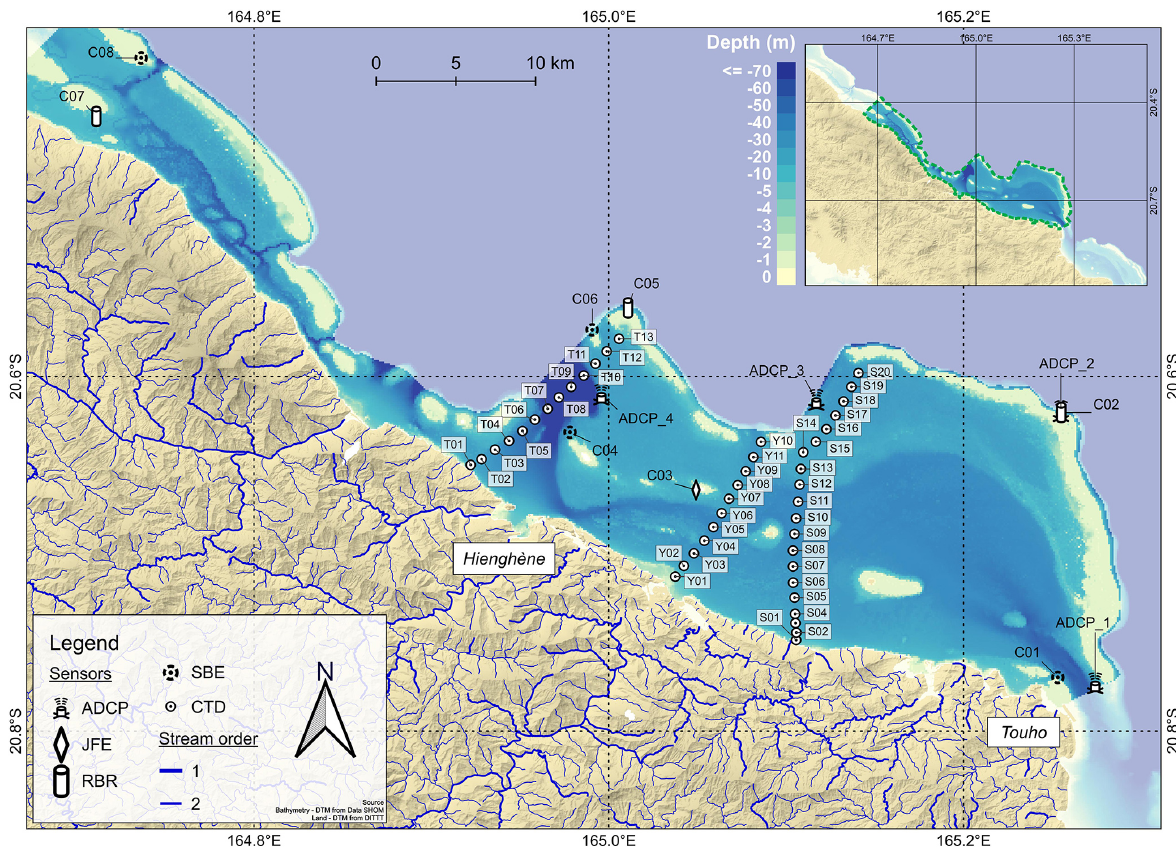
Figure A1. Observational strategy deployed during SPHYNX field experiment. ADCP: acoustic doppler current profiler; JFE: INFINITY- CTW; RBR: RBRduo T.D or RBRduet T.D; CTD: conductivity – temperature – depth ; SBE: SBE 56.